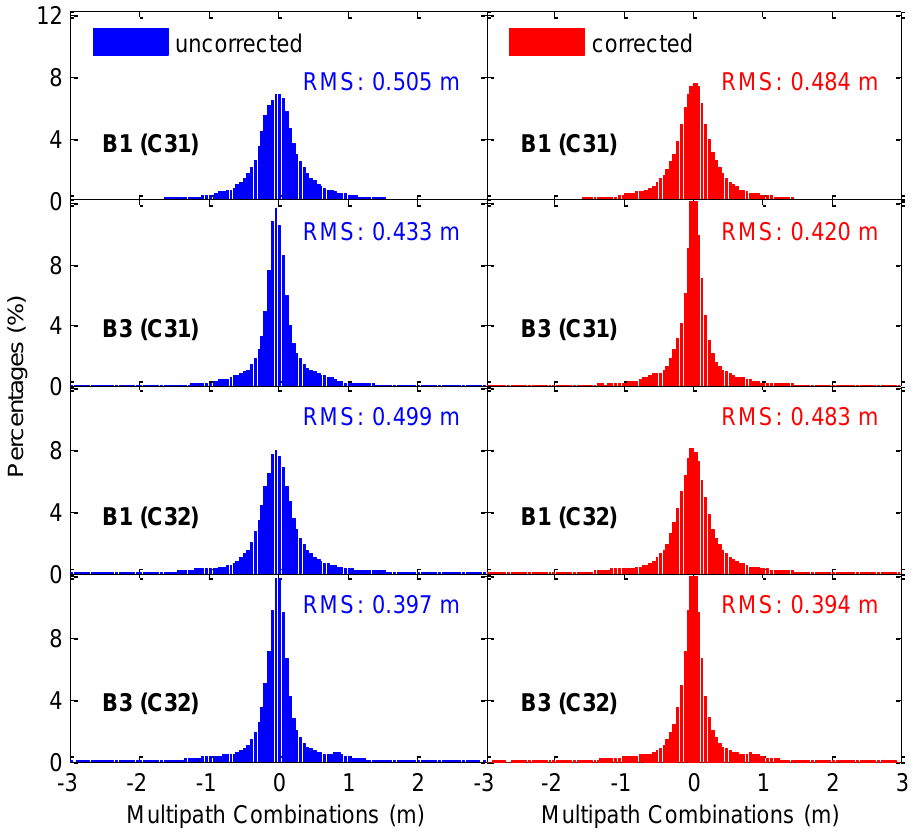
Figure 16. Distribution of corrected MP combination time series with the traditional SICB correction model for BDS-2 IGSO and MEO satellites.